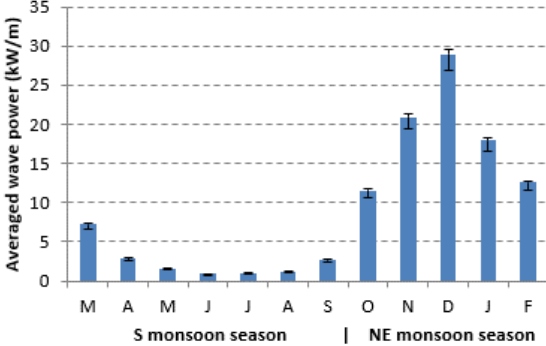
Fig. 7. Monthly wave power, averaged for the entire 30-m contour line . The “error bars” indicate the variation of wave power when the bathymetric contour shifts from 20-m depth (lower bound) to 50-m depth (upper bound).